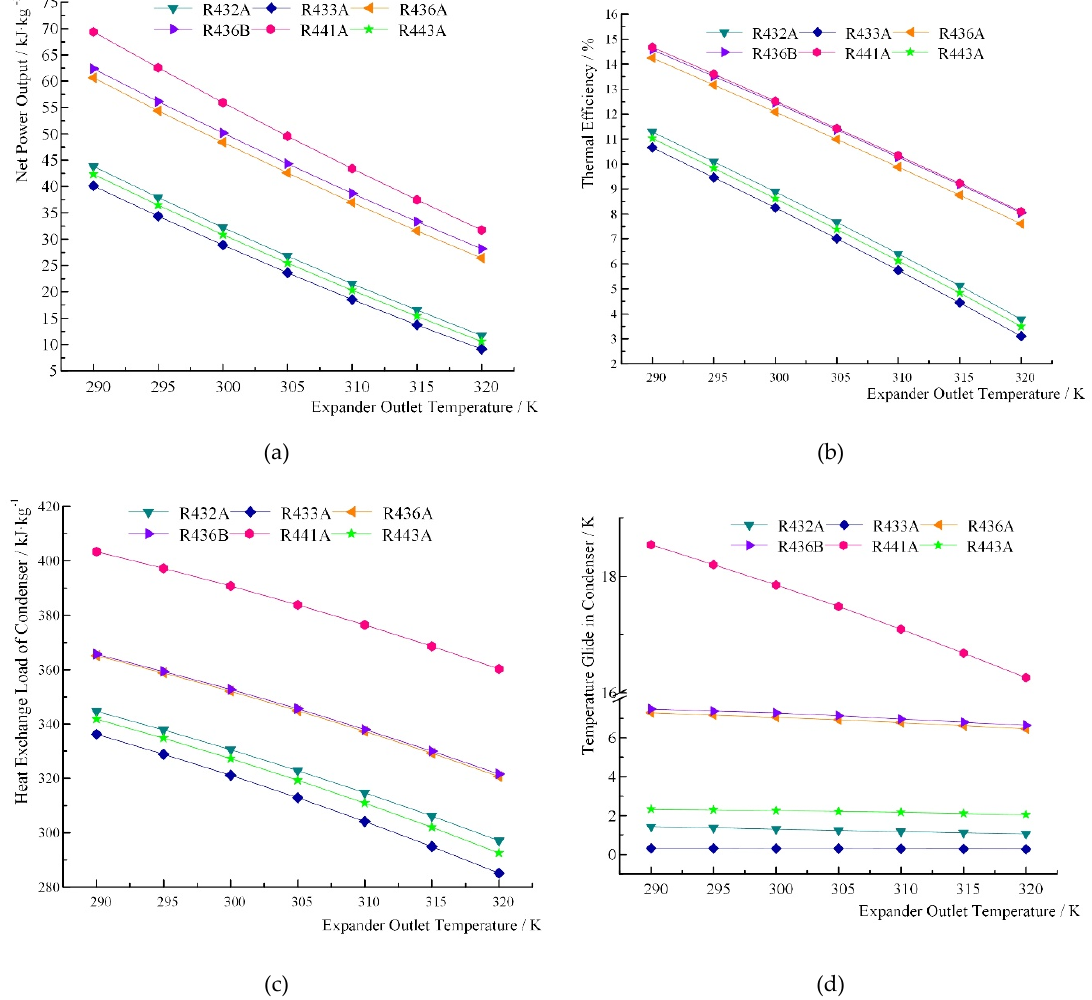
Figure 6. Variation trend of four indexes with the increase of expander outlet temperature: (a) net work; (b) thermal efficiency; (c) heat exchange load of condenser; (d) temperature glide in condenser.